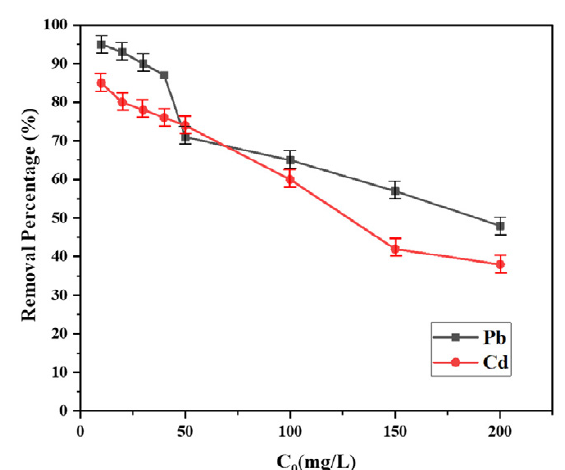
Fig. 8. Effect of Cd(II) and Pb(II) initial concentrations on the removal percentage (±1) by pectin/ γ -Fe